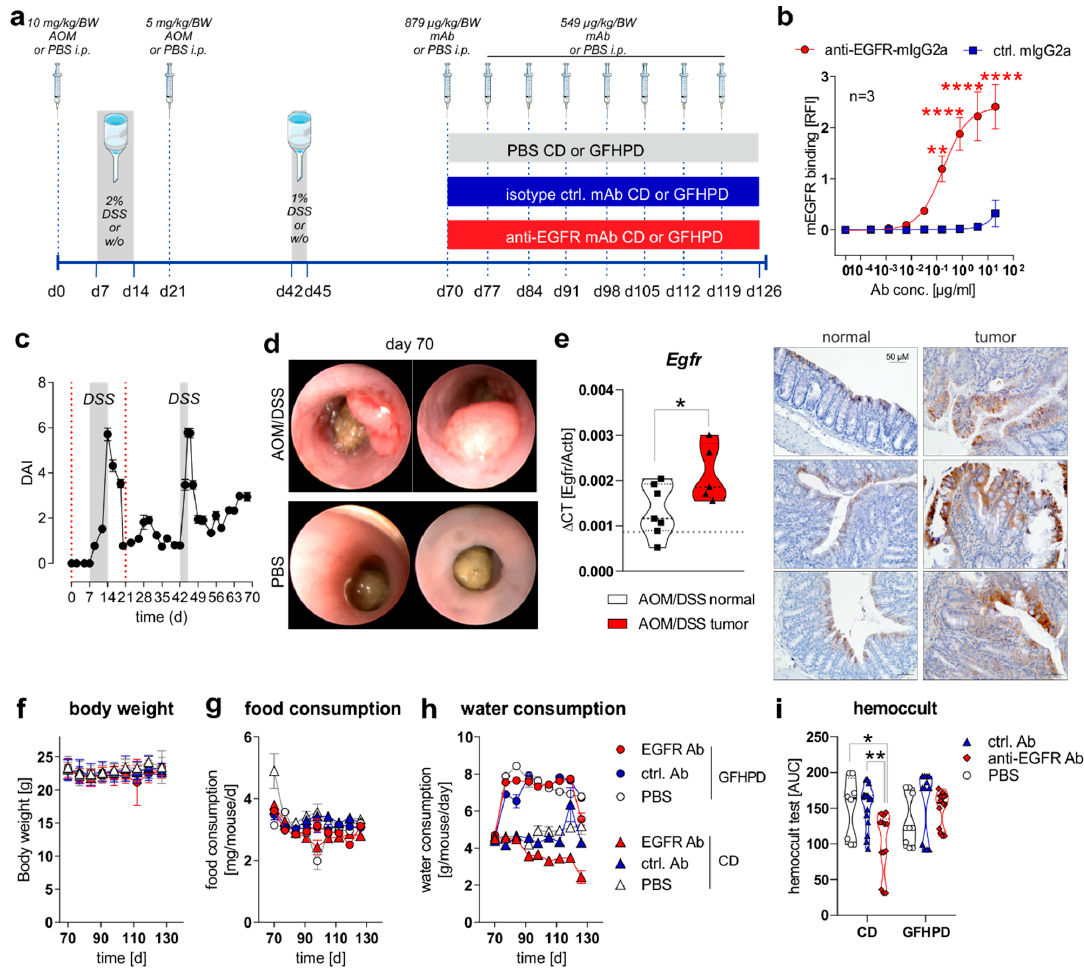
Figure 1. EGFR expression is elevated in CRC tumors and anti-EGFR Ab treatment reduces fecal occult blood levels in AOM/DSS-treated mice. ( a ) Schematic overview of induction of colitis-driven colorectal carcinomas by AOM/DSS treatment in female C57BL/6J mice ( n = 88) between days 0 and 70. Control mice received PBS instead of AOM/DSS ( n = 19) between days 0 and 70. At day 70, indicator mice ( n = 9 AOM/DSS-treated; n = 8 PBS-treated) were sacrificed and tissues were sampled for further analysis. Remaining AOM/DSS-treated mice were further subdivided at day 70 into two different dietary intervention groups receiving control diet (CD; n = 39) or glucose-free, high-protein diet (GFHPD; n = 40) until day 126. Dietary interventions were performed in the presence or absence of weekly intraperitoneal ( i.p. ) application of PBS ( n = 9 CD; n = 9 GFHPD), anti-EGFR Ab ( n = 15 CD; n = 16 GFHPD) or a ctrl. antibody ( n = 15 CD; n = 15 GFHPD) between day 70 and 126. PBS-treated control mice were fed either CD ( n = 5) or GFHPD ( n = 6) between day 70 and 126. AOM = azoxymethane; DSS = dextran sodium sulfate; anti-EGFR-mAb = 7A7-mIgG2a; isotype ctrl. mAb = irrelevant mIgG2a; mAb = monoclonal Ab. ( b ) Concentration-dependent binding of anti-EGFR-mIgG2a or ctrl.-mIgG2a to recombinant murine EGFR was analyzed by ELISA experiments. Mean ± SEM of three independent experiments is presented. ( c ) Disease activity index (DAI) of AOM/DSS-treated mice ( n = 88) from day 0 to 70. ( d ) Representative images of endoscopy analyses of AOM/DSS or PBS-treated indicator mice at day 70. ( e ) Egfr mRNA expression was quantified by qPCR and related to Actb mRNA expression in normal or tumor colonic tissues collected from AOM/DSS-treated mice at day 70. Grey dotted line indicates median values of PBS-treated control mice at day 70 (left panel). Representative images of immunohistochemistry staining of EGFR in paraffin-embedded normal and tumor colonic biopsies ( n = 3 each) were collected from AOM/DSS-treated mice at day 70 (right panel). Scale bar = 50 µM. ( f – h ) Body weight, food consumption, and water consumption were routinely monitored between days 70 and 126. ( i ) Fecal occult blood was determined every second day using a hemoccult test. Results are presented as the area under the curve (AUC) from analyzed mice. * p ≤ 0.05, ** p ≤ 0.01. **** p ≤ 0.0001.